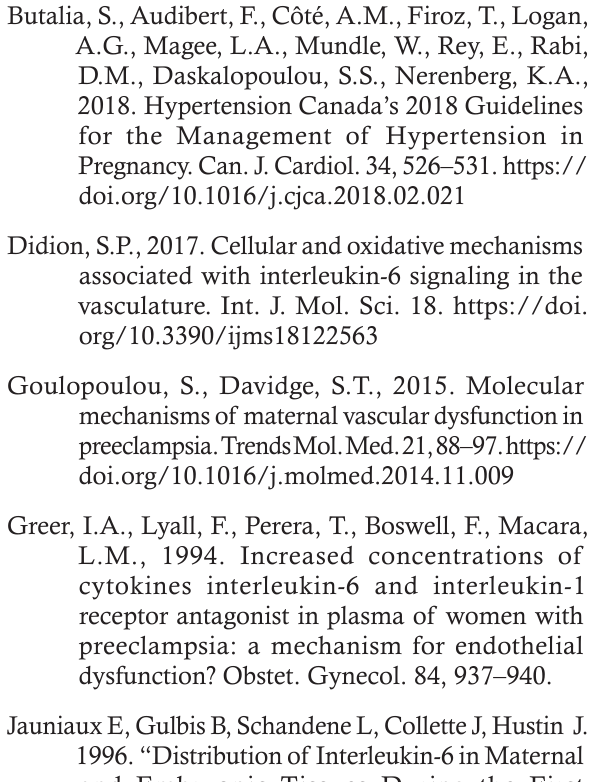
Comparison of Serum Interleukin-6 (Il-6) Levels Between Patients